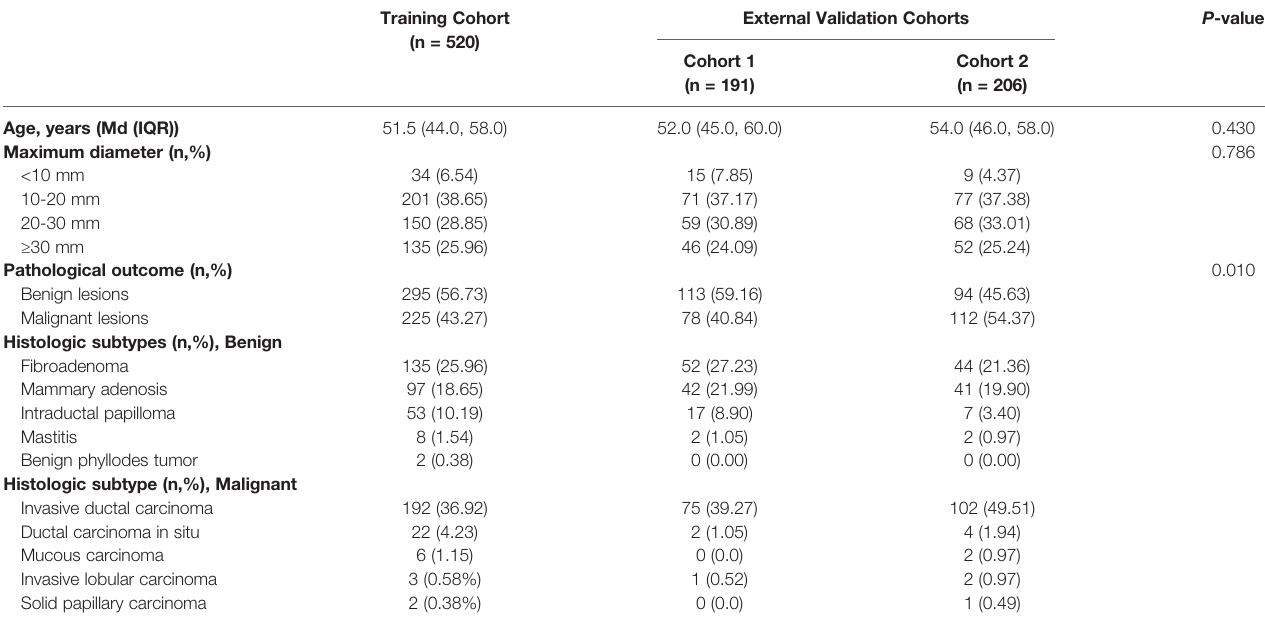
Training Cohort (n =